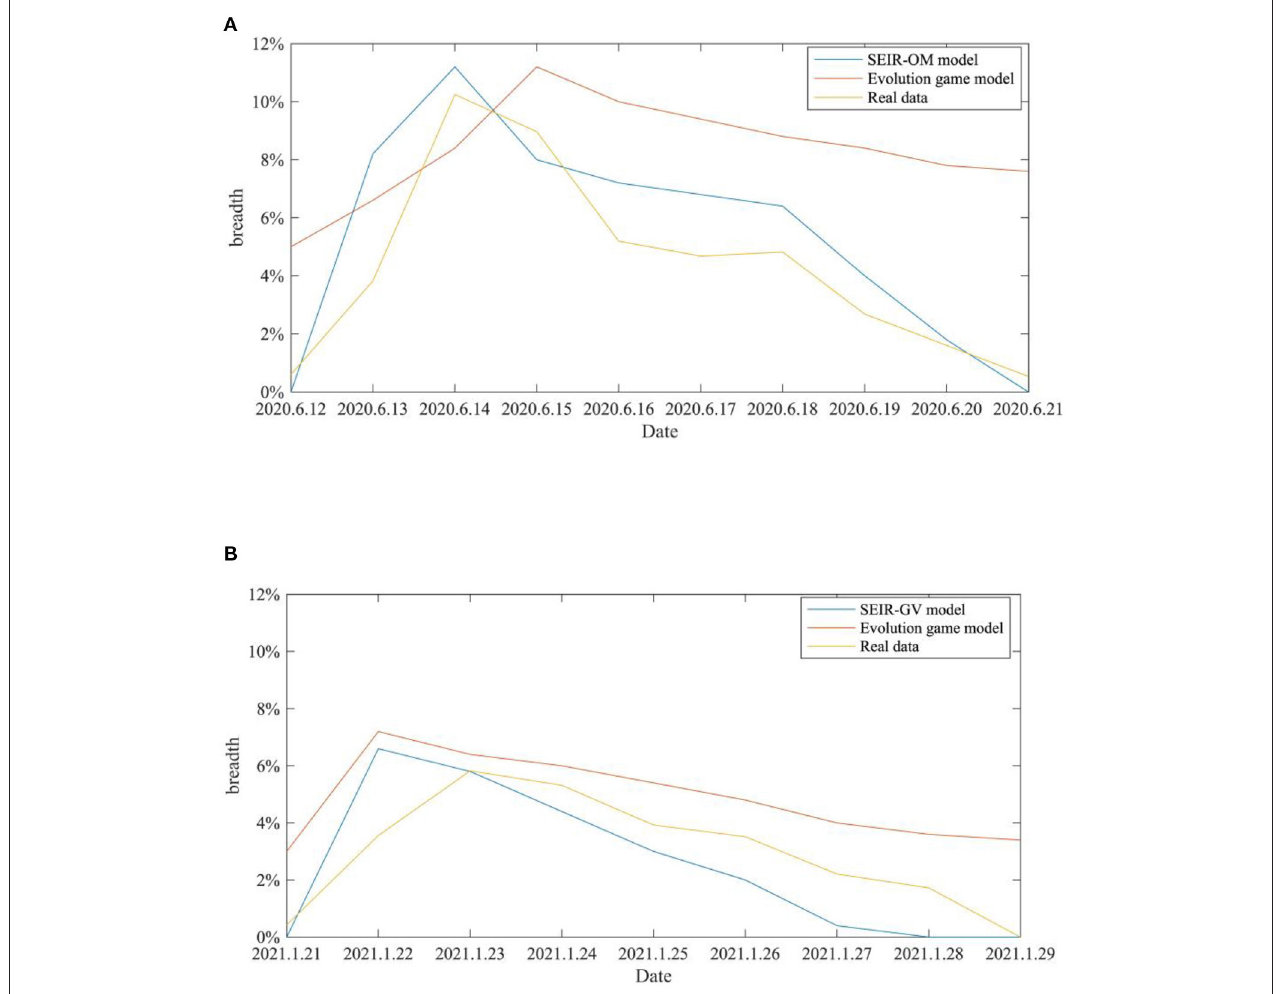
FIGURE 21 | Comparison of the rumor diffusion ranges in two events. (A) COVID-19 was detected on the surface of the imported salmon cutting board in Beijing. (B) COVID-19 was detected on the surface of the imported cherry in Wuxi.